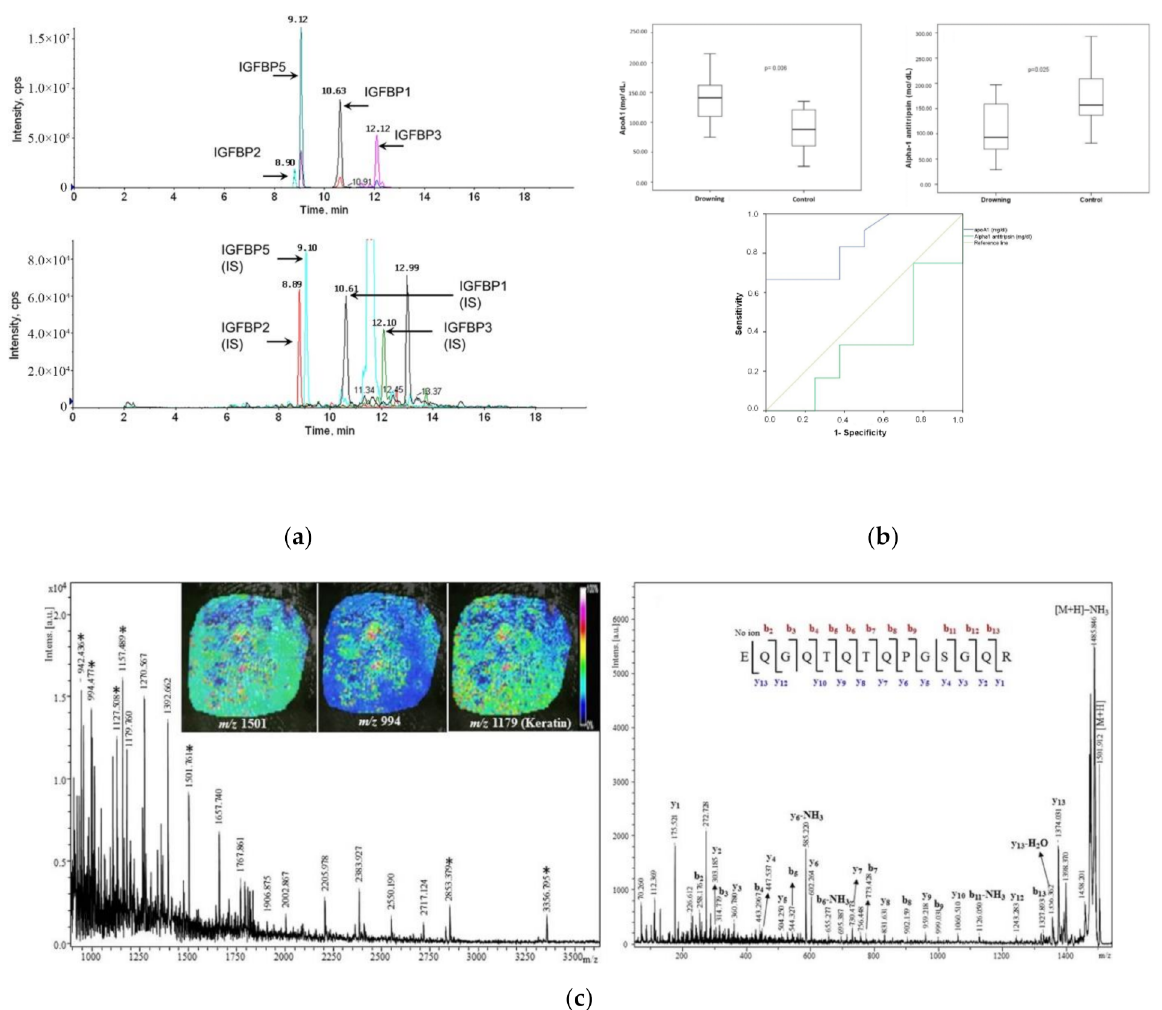
Figure 6. Other applications of forensic proteomics for human samples ( a ) LC–MS/MS chromatograms of IGFBP 1, 2, 3, and 5 and stable isotope-labeled peptides used as internal standards. Figure adapted from [48], Copyright (2019), with permission from Elsevier. ( b ) Plasma levels of apolipoprotein A1 (ApoA1) and alpha-1 antitrypsin in drowning and control samples (Student unpaired t -test) and Receiver Operating Characteristic (ROC) curves of ApoA1 and alpha-1 antitrypsin levels in the prediction of death by drowning. Figures were adapted from [50], under the terms of the Creative Commons Attribution License (CC BY 4.0) https://creativecommons.org/licenses/by/4.0/ (accessed on 3 March 2021). ( c ) Matrix-assisted laser desorption ionization-time of flight (MALDI-ToF) imaging mass spectrometry (IMS) of a fingermark contaminated with vaginal fluid (with the matched tryptic peptides of cornulin were asterisked) and MS/MS spectrum of cornulin tryptic peptide m/z 1501.91. Ion intensity maps of m/z 1501, 994 (peptides of cornulin), and 1179 (a peptide of human cytoskeletal keratin) were imaged. Figure reprinted by permission from Springer Nature, International Journal of Legal Medicine [35], Copyright